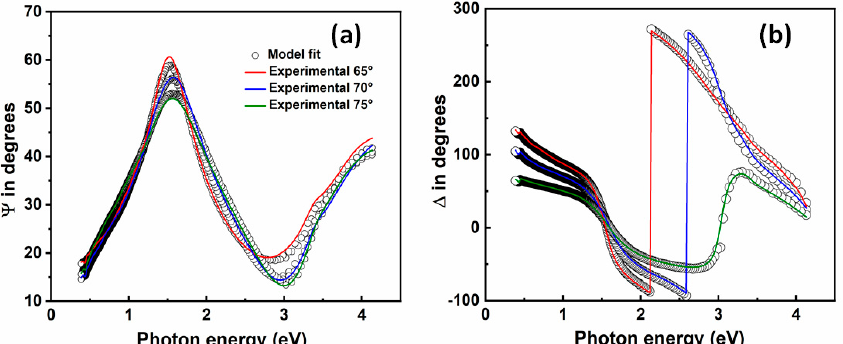
Figure 8. Variable angle spectroscopic ellipsometry measurements of reduced graphene oxide stabilized with poly(sodium 4-styrenesulfonate) on SiO 2 /Si substrates. Experimental and model generated ψ ( a ) and Δ ( b ) data fits at different angles of incidence.